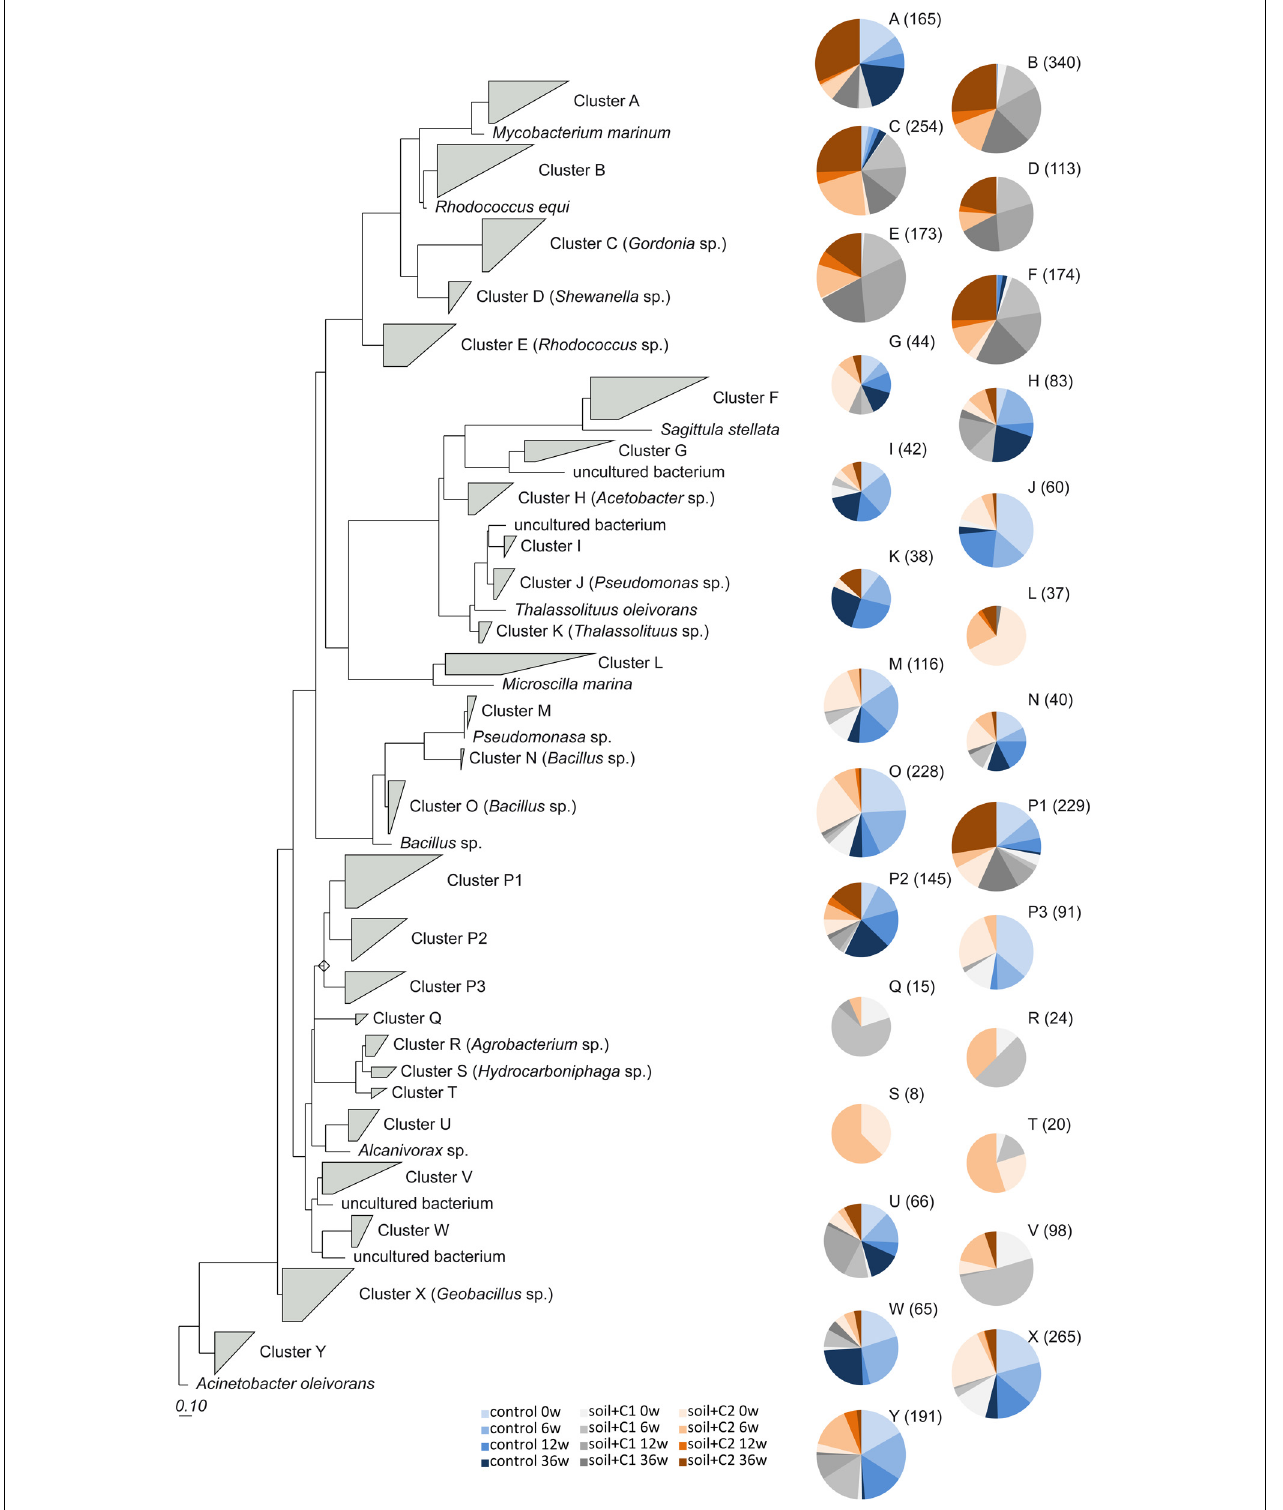
FIGURE 6 | Phylogenetic tree calculated with the maximum parsimony algorithm based on the reference sequences on amino acids of alkB gene fragments provided by RDP. 454 sequencing amplicons were included. For conciseness, sequences closely related to reference sequences were grouped into clusters from A to Y. Bold numbers indicate the number of